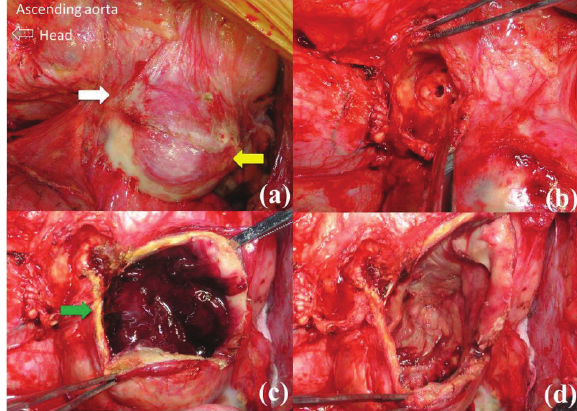
Figure 5: Aneurysm resection. (a) Proximal small vein aneurysm near the proximal anastomosis (white arrow) and large aneurysm anterior to the right atrium (yellow arrow). (b) Lumen within the incised proximal aneurysm. (c) A large amount of fresh thrombi in the distal aneurysm (green arrow). (d) Luminal cavity within the distal aneurysm after